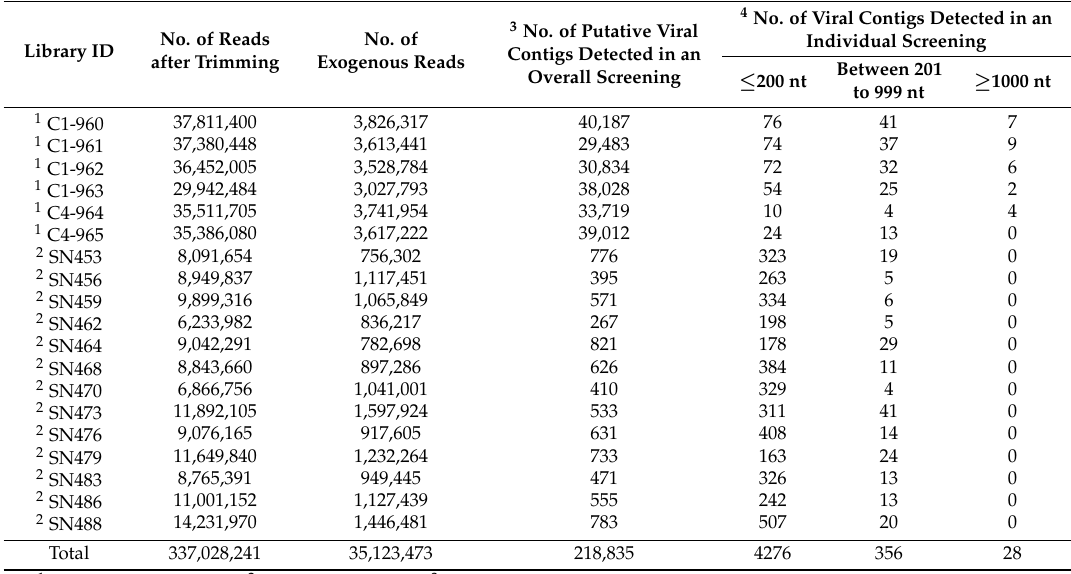
Table 2. Reads and contigs count information of each RNA-seq and sRNA library. The number of assembled viral contigs was organized according to their size.